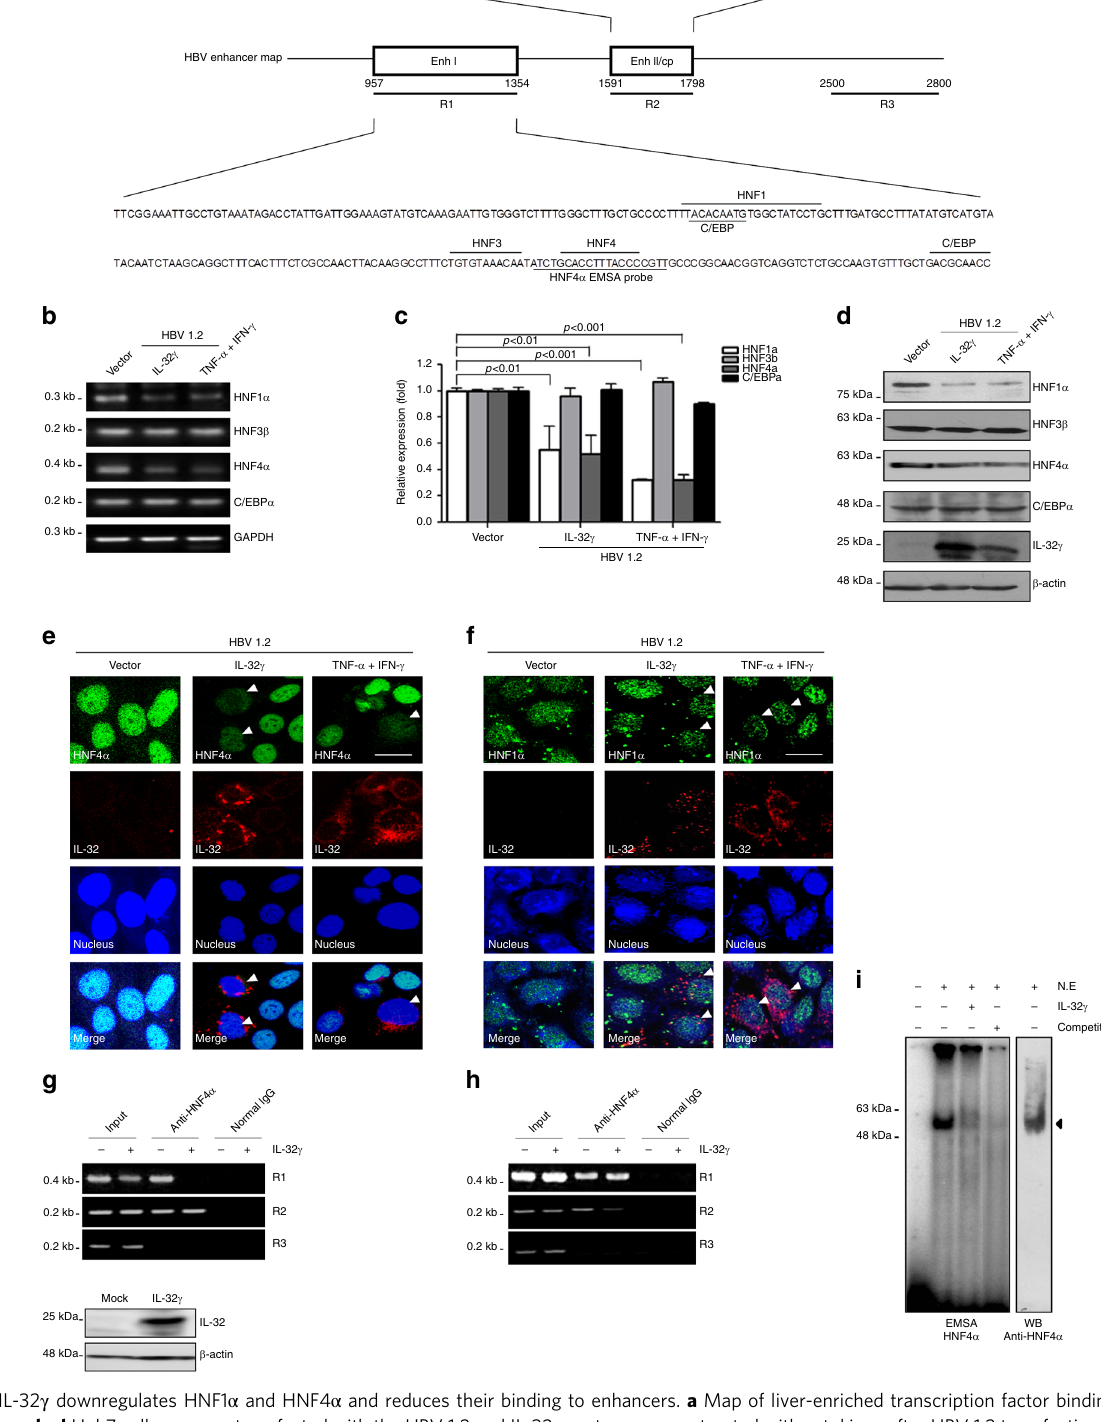
Fig. 4 IL-32 γ downregulates HNF1 α and HNF4 α and reduces their binding to enhancers. a Map of liver-enriched transcription factor binding to HBV enhancers. b – d Huh7 cells were co-transfected with the HBV 1.2 and IL-32 γ vectors or were treated with cytokines after HBV 1.2 transfection. The levels of transcription factors were determined by semi-quantitative RT-PCR ( b ), real-time PCR ( c ), or western blot analysis ( d . e , f ) Effect of IL-32 γ and cytokines on the expression of HNF1 α and HNF4 α was analyzed by confocal fl uorescence microscopy. At 24 h after transfection or treatment, immuno fl uorescence assay was performed using indicated antibodies (magni fi cation, ×400; scale bar, 50 μ m.). g , h Chromatin immunoprecipitation (ChIP) assay. Control or IL- 32 γ vector was transfected into Huh7 cells and ChIP assay was performed using anti-HNF4 α ( g ) or anti-HNF1 α ( h ) antibody. The level of the IL-32 γ protein was determined by western blotting. The regions for R1 – R3 were shown in above diagram ( a ). i Electrophoretic mobility shift assay (EMSA). An aliquot of 2 µ g nuclear extracts was used. A cold competitor (50-fold) was used as a negative control. The protein complex was con fi rmed by western blotting using anti-HNF4 α antibody. Data ( c ) was obtained from three independent experiments (mean ± S.D.). p < 0.001, p < 0.01 by Student ’ s t